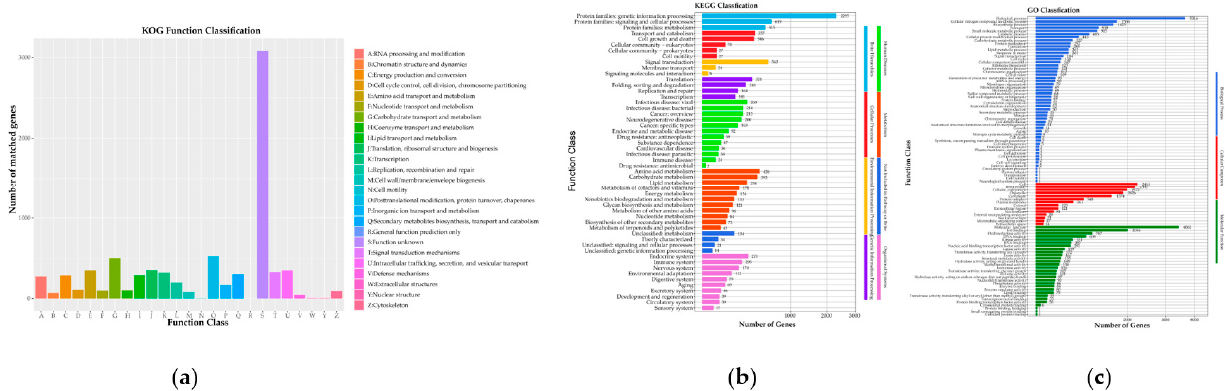
Figure 2. Functional annotation of C. pseudotenuipes gene-encoding proteins in the ( a ) Evolutionary Genealogy of Genes: Non-supervised Orthologous Groups of proteins (EggNOg), ( b ) Kyoto Encyclopedia of Genes and Genomes (KEGG), and ( c ) Gene Ontology (GO) databases.